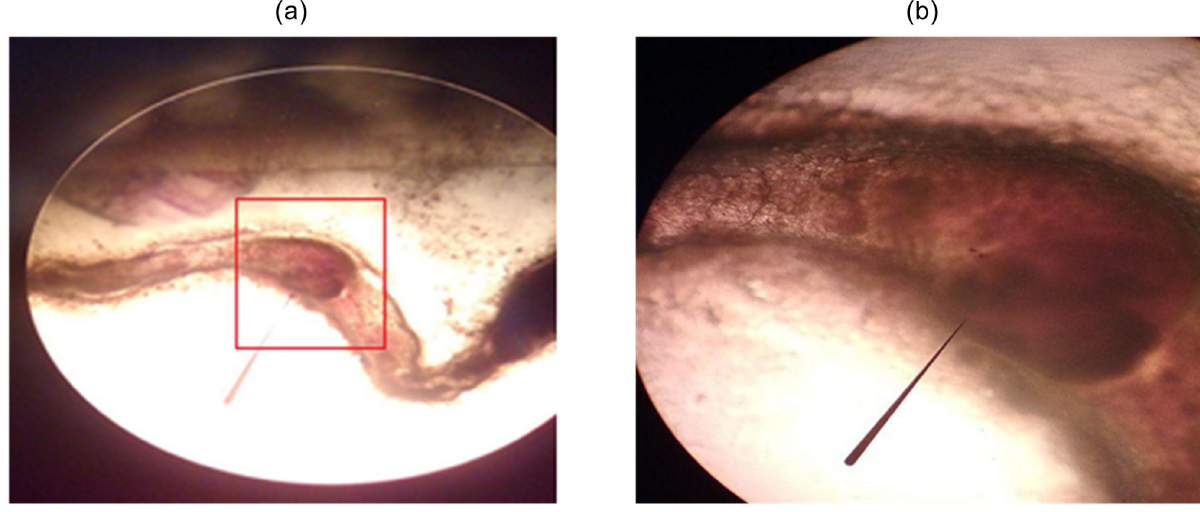
Fig 11. An alien object in termite guts with 4x (a) and 10x magnifications (b).